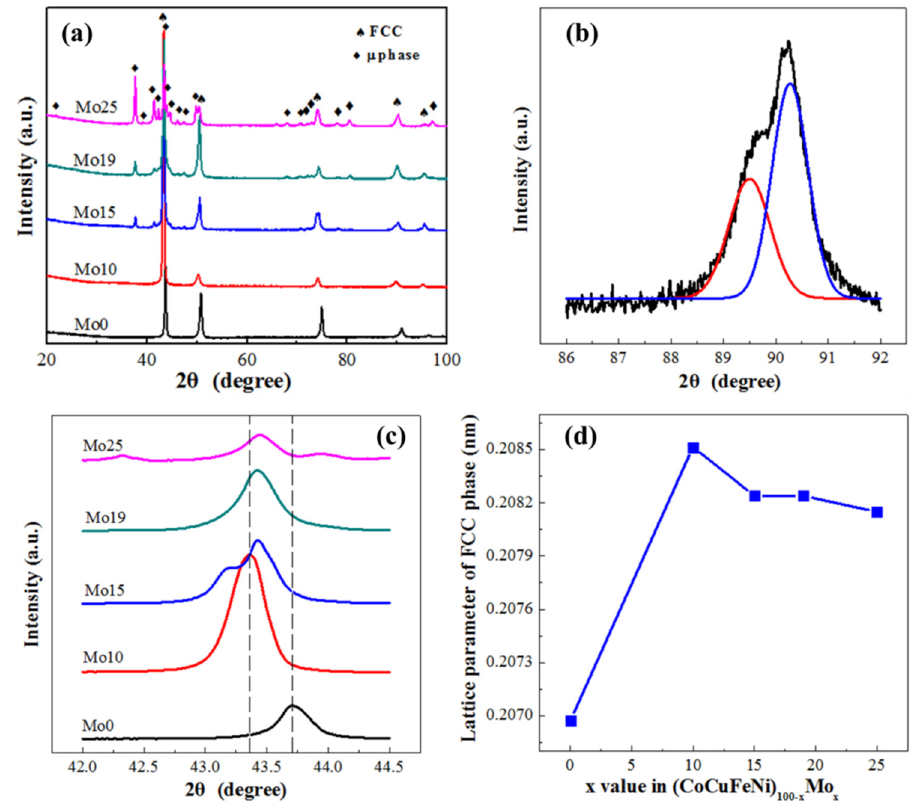
Figure 1. ( a ) X-ray diffractometer (XRD) patterns of (CoCuFeNi) 100- x Mo x HEAs. ( b ) Fitting pattern of the reflection peak between 86° and 92° of (CoCuFeNi) 85 Mo 15 HEA. ( c ) The detailed image of (111) peak of the face-center-cubic (FCC) phase. ( d ) Lattice parameter of the FCC phase vs. the content of Mo.